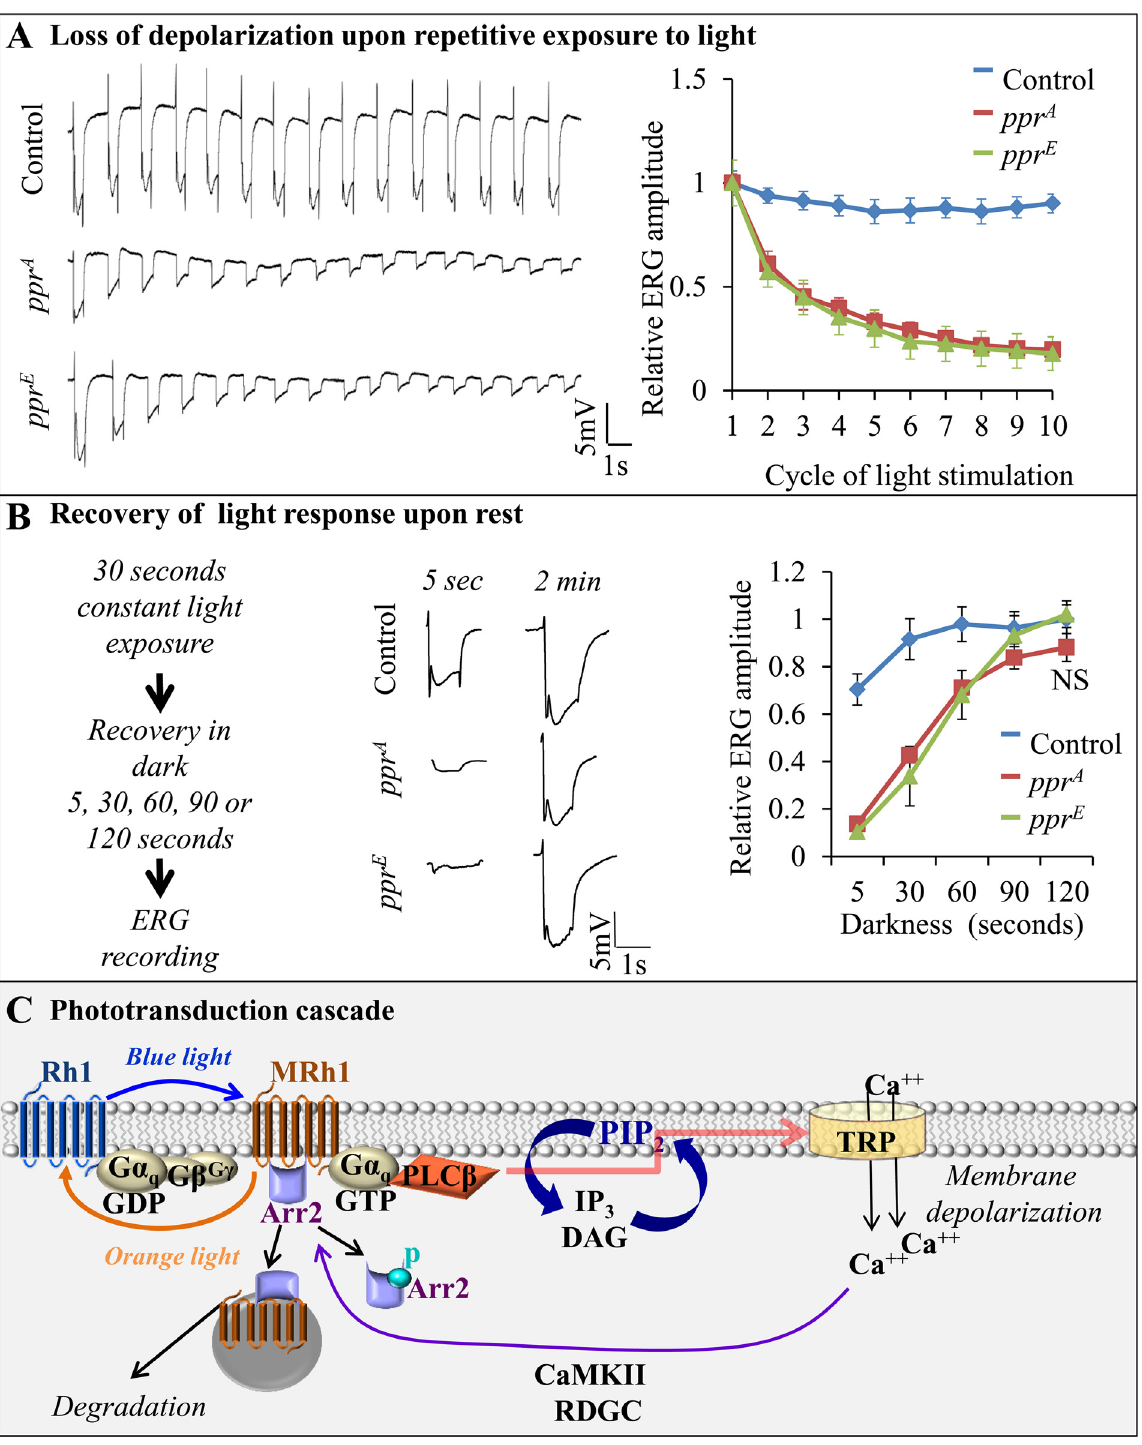
Fig 3. ppr is required to maintain PR depolarization upon repetitive stimulation. (A) ERG traces during repetitive light stimuli (1 sec light and 1.5 sec dark) recorded from eye clones of control, ppr A and ppr E (left). Quantification of the change in ERG amplitude, relative to the amplitude of the response to the initial light stimulus, is shown on the right. Error bars represent ± SEM. (B) Recovery time of ERG amplitude (light response) in control, ppr A and ppr E eye clones. Following 30 sec of light exposure (~1,700 Lux), ERG amplitudes were measured after 5, 30, 60, 90 or 120 sec of recovery in dark. ERG traces after 5 sec and 2 min are shown (middle), and quantification of the relative ERG amplitude is shown on the right. Error bars represent ± SEM; NS (two-tailed Student ’ s t test not significant). (C) Schematic presentation of the phototransduction cascade and the mechanism of Rh1 recycling and endocytosis.